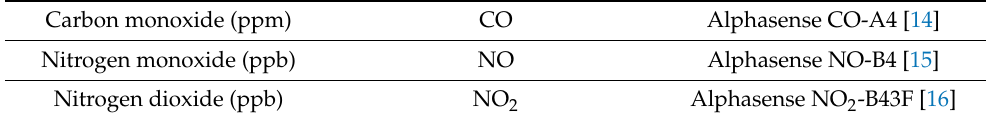
Table 1. Examined air